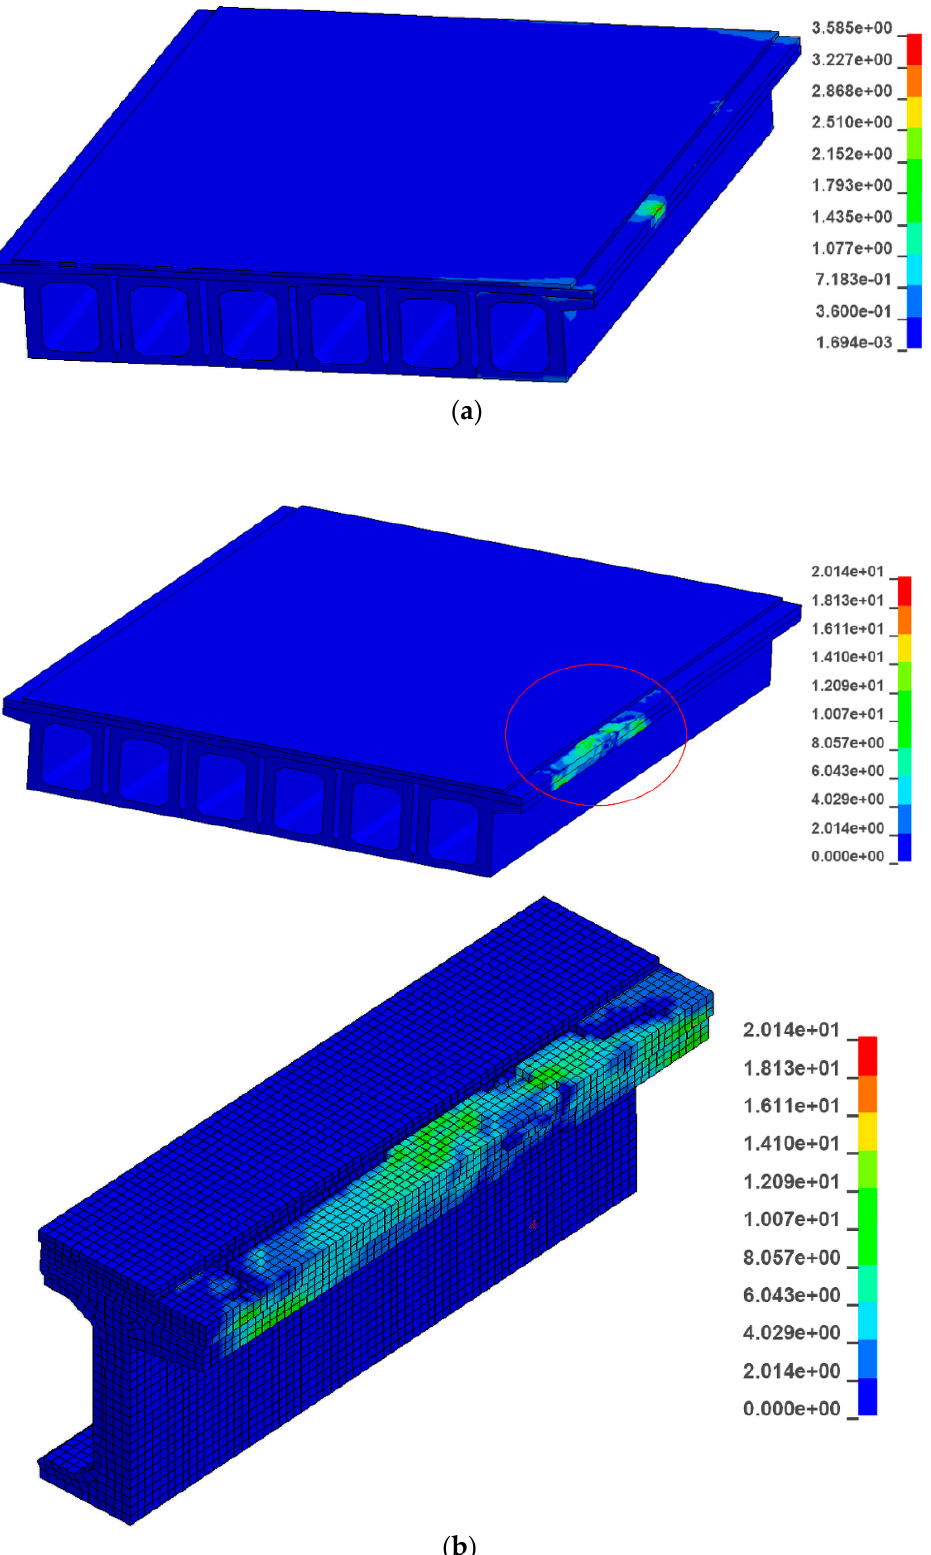
Figure 17. Maximum tensile stress diagram: ( a ) fabricated guardrail and ( b ) traditional guardrail.